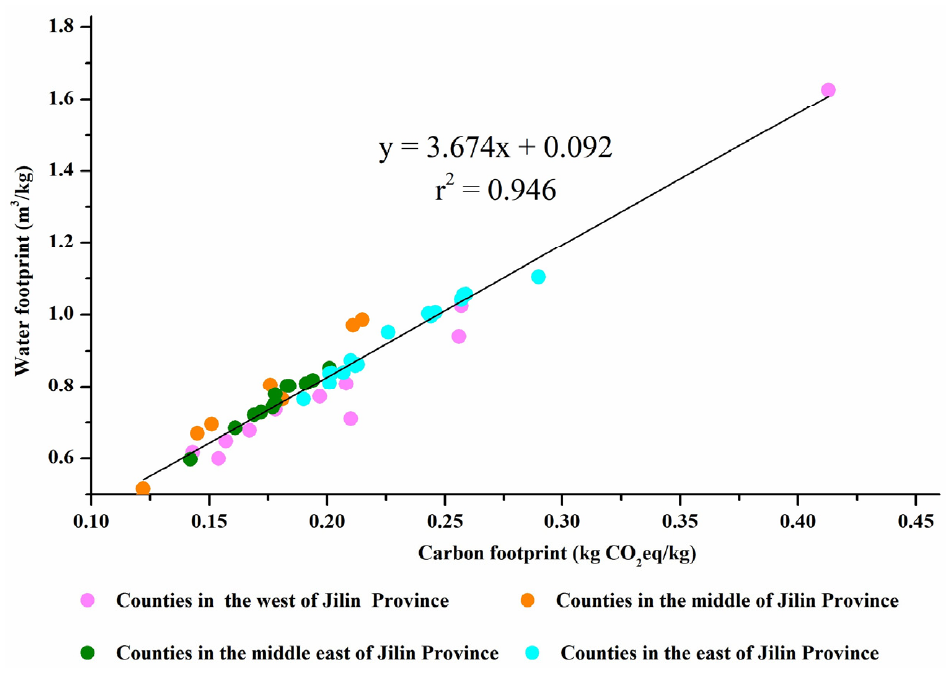
Figure 9. Relationship between the spatial distributions of the CF and